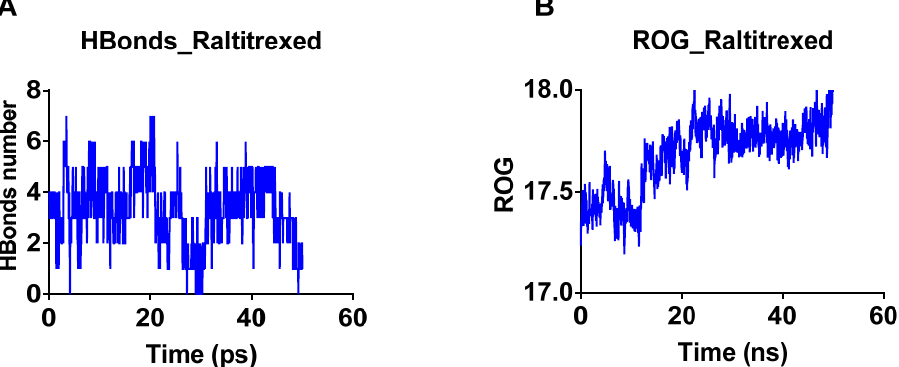
Figure 3. RMSD and RMSF of the interaction of raltitrexed with Trypanosoma brucei dihydrofolate and consistent binding of raltitrexed with TbDHFR-TS. The slight changes (Figure 4B) in reductase. ( A ) RMSD of raltitrexed for 50 ns. ( B ) RMSF of raltitrexed for 50 ns. ROG indicate the general compactness of the raltitrexed–TbDHFR-TS complex.